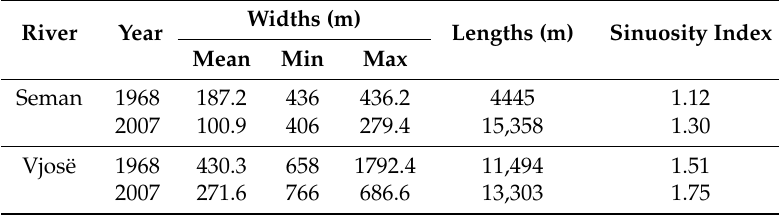
Table 11. Hydromorphological parameters derived from historical images and orthophotos, rivers Seman and